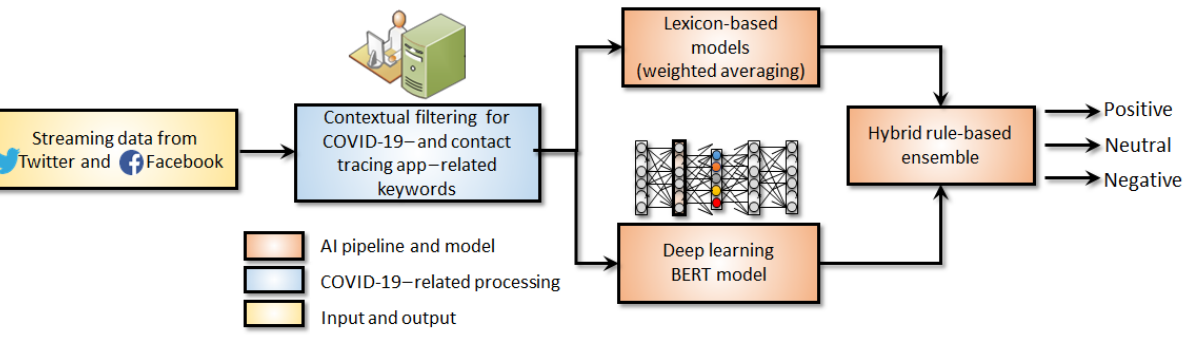
Figure 1. Hybrid rule-based ensemble model for sentiment classification of social media data. AI: artificial intelligence; BERT: Bidirectional Encoder Representations from